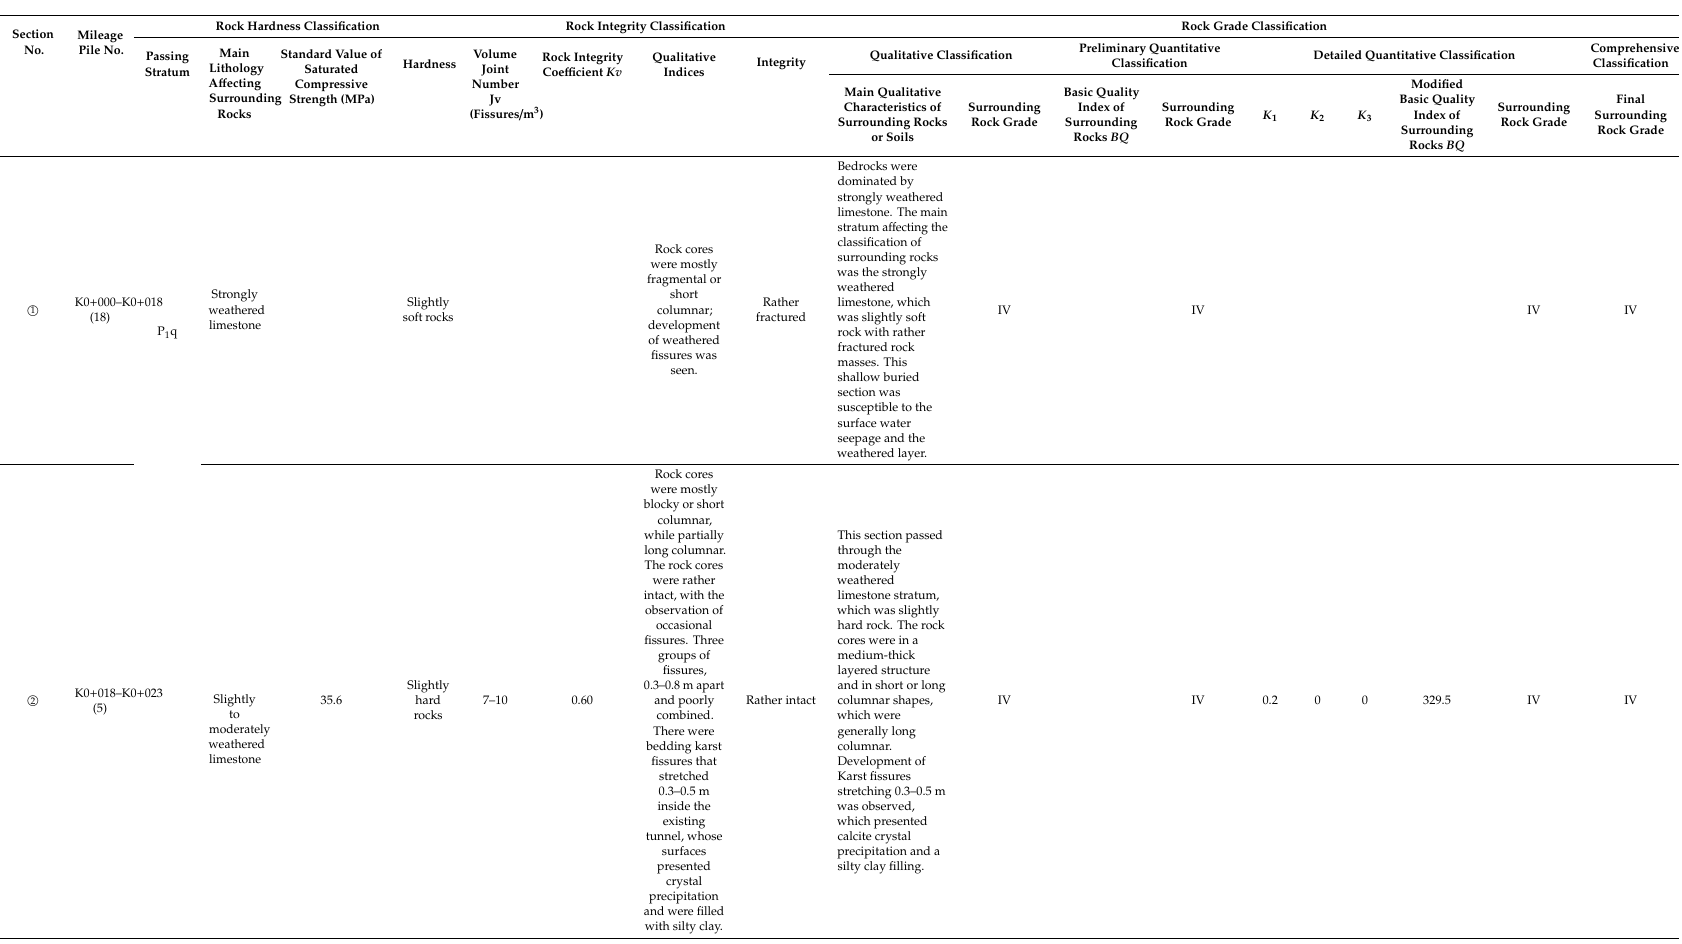
Table 3. Final surrounding rock classification results for the new